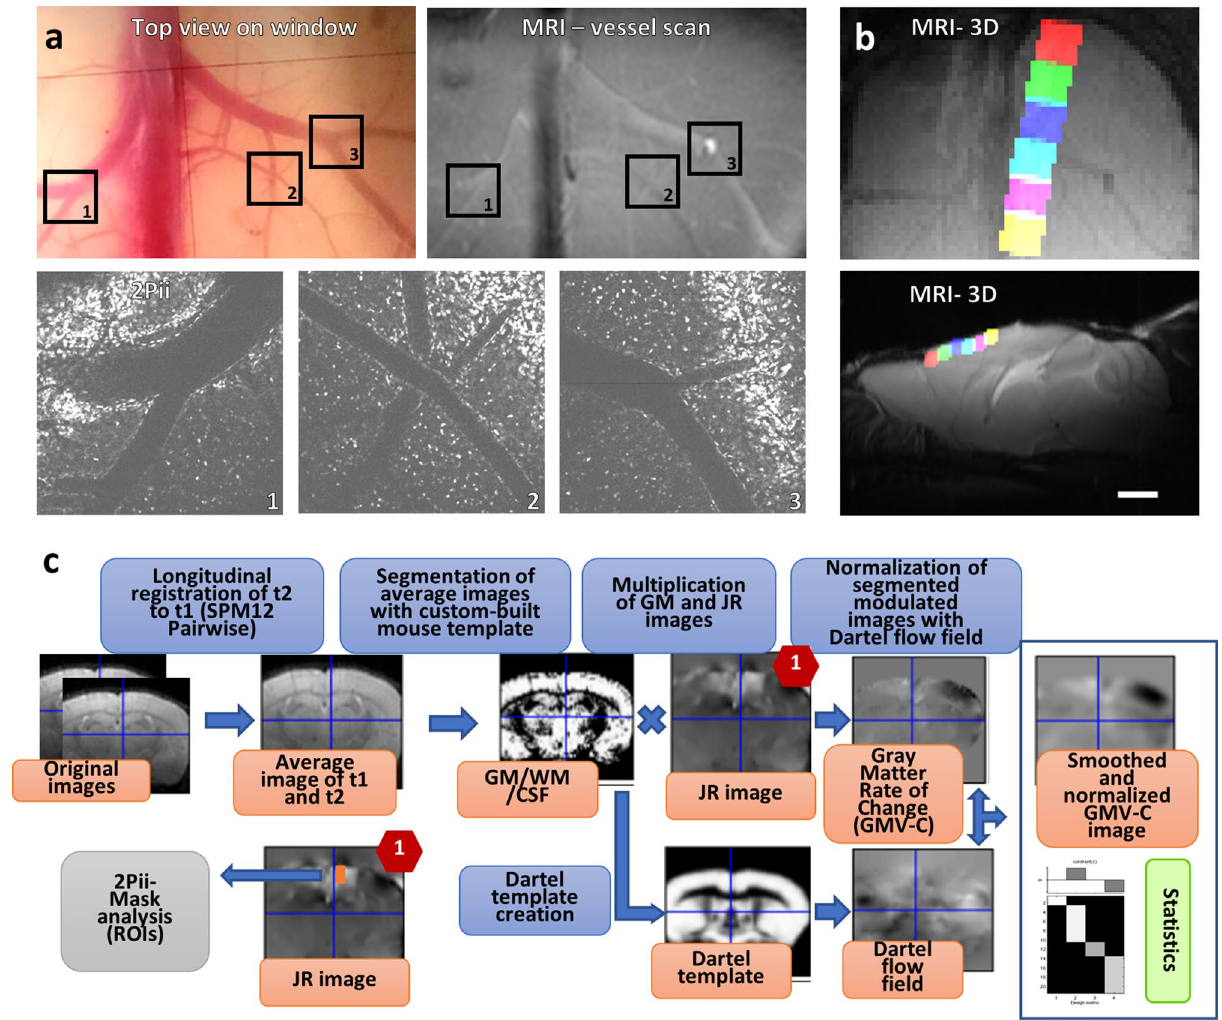
Figure 2. Cross-modal affine image registration using vessel branchings as fiducial points and VBM analysis workflow. ( a ) Vessel branchings are visible in MRI as well as 2Pii without any additional contrast agent. Upper left panel shows view on exposed brain surface after window surgery, regions 1–3 indicate the positions of vessel branches in MRI and 2Pii. ( b ) Six partially overlapping 2Pii-stack-masks of one animal registered on the corresponding MR image. Average intensity projections; up: horizontal view, bottom: sagittal view. Scale bar = 2 mm. ( c ) Longitudinal registration and processing of MRI 3D images for VBM. Longitudinal nonlinear registration was performed for each subject between timepoints (t1 = baseline, t2 = 1 week or 12 weeks), which yielded resulting average and Jacobian Rate (JR) images. The average images were pre-segmented in three tissue probability maps [gray matter (GM), white matter (WM), cerebrospinal fluid (CSF)] and multiplied by the JR-images. From these, a Dartel prior knowledge template was created and the resulting flow fields were used to normalize the JR-modulated tissue maps into Paxinos space. They were finally smoothed and statistically analysed in SPM second-level